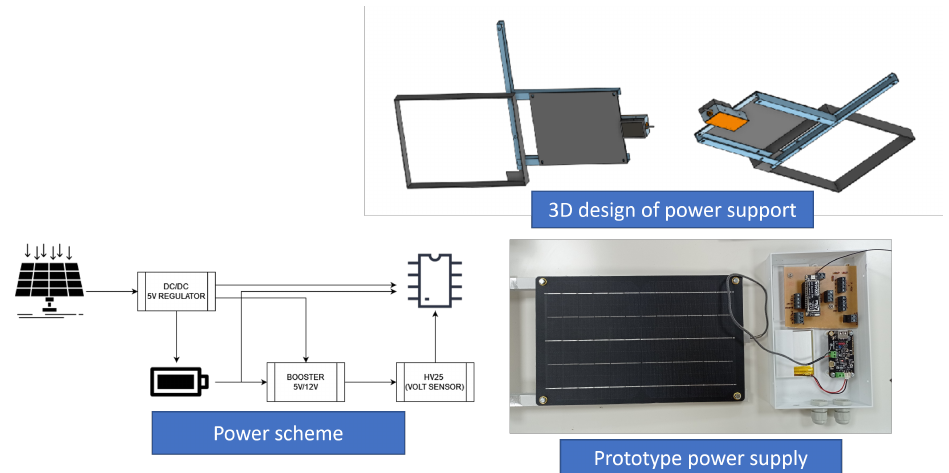
Figure 9. Power supply scheme of the system and prototype